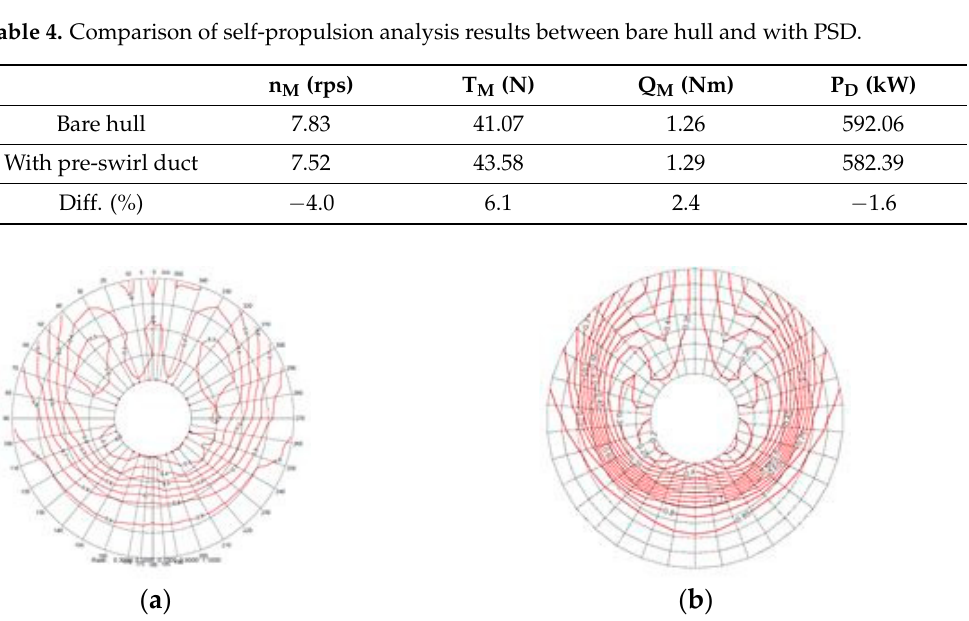
Figure 7. Comparison of nominal wake between EFD and CFD: ( a ) W n = 0.452 (EFD); ( b ) W n = 0.440 (CFD) [25].